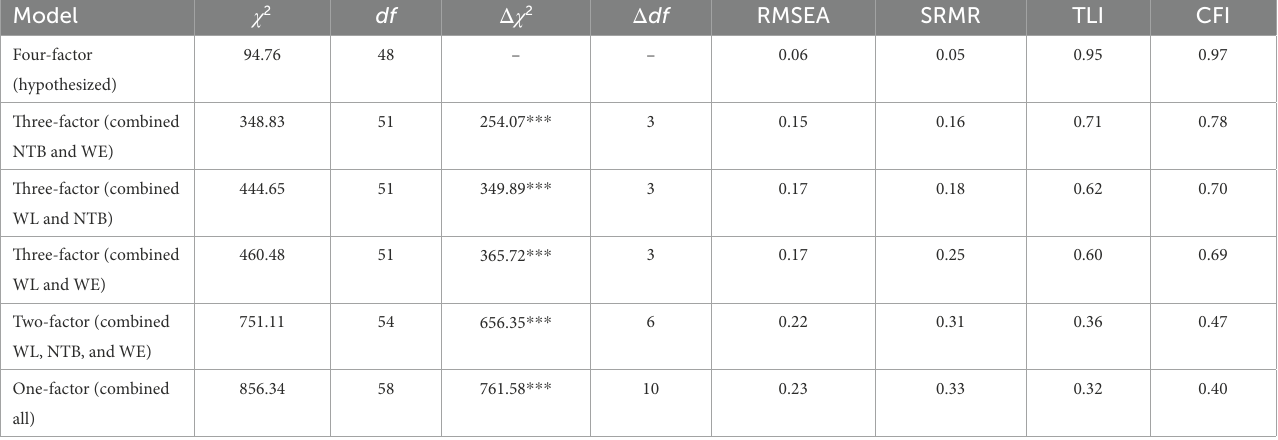
TABLE 3 Discriminant validity with comparison of alternative measurement models.